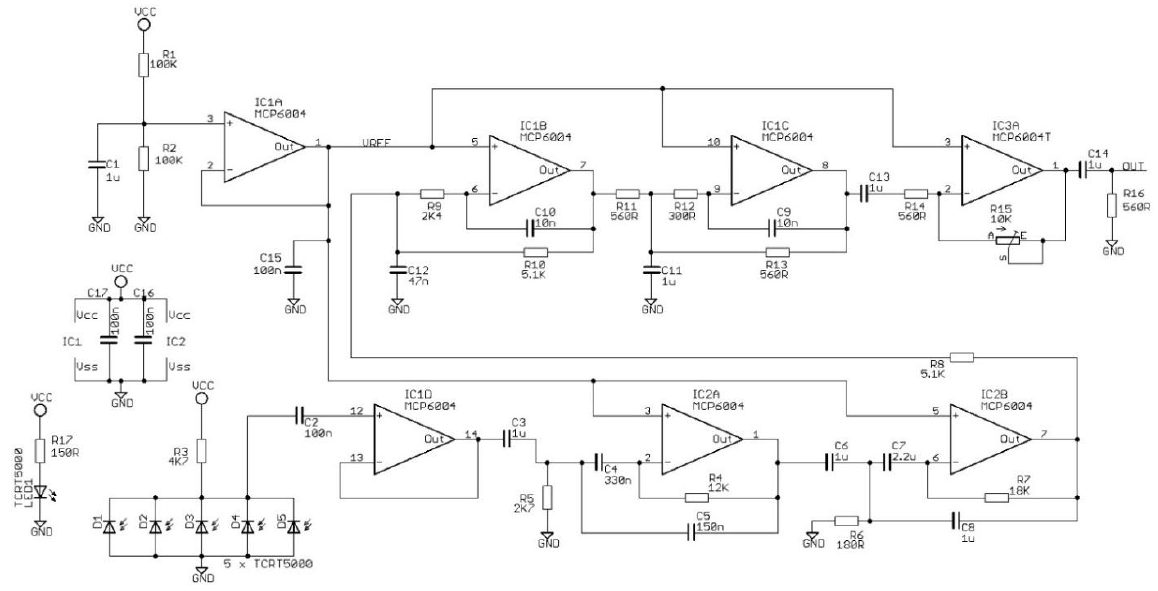
Figure 6. Schematic Description of the filters and operational amplifier attached to the phototransistors. HPF, LPF stands for high-pass, low pass filters respectively and AMP for